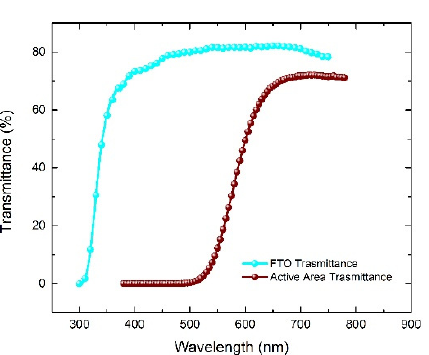
Figure 10. Glass substrate and module transmittance. Table 2. Transmittance values of the various components of the module and relative area in cm 2 .